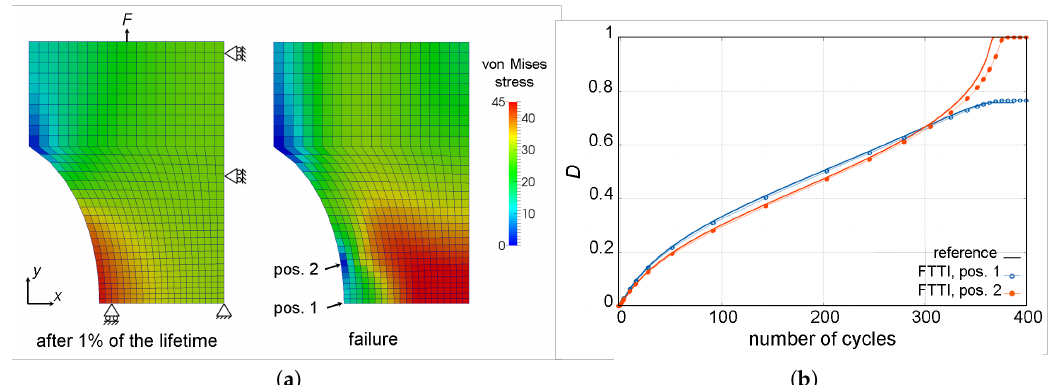
Figure 4. ( a ) Evolution of the stress distribution map during the lifetime under sinusoidal load oscillations applied on the top boundary in y -direction. ( b ) Evolution of damage in the highly stressed regions of the